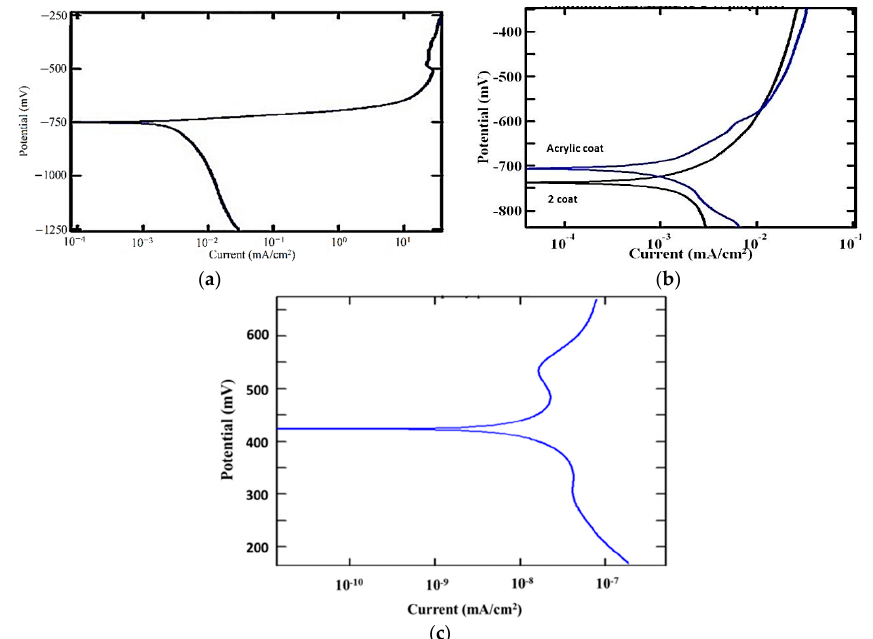
Figure 7. Current versus potential graph for measuring corrosion rate: ( a ) Acrylic paint ED coat; ( b ) 2-coat polyester without primer; ( c ) 3-coat polyester with epoxy primer.